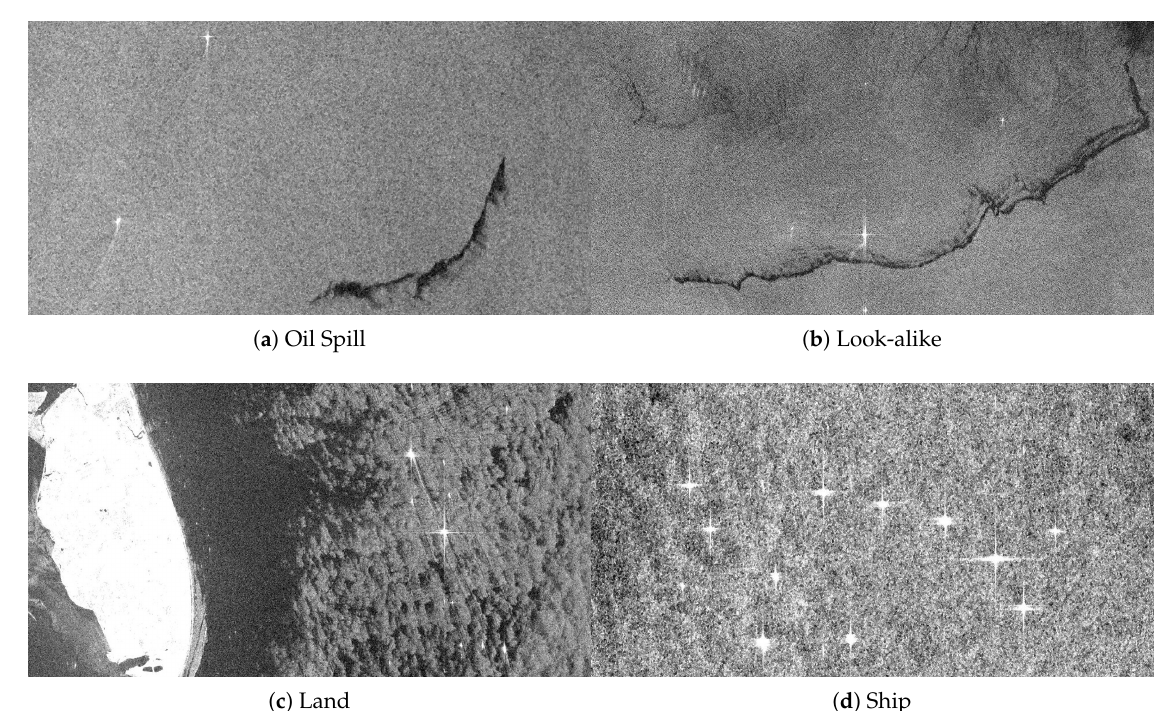
Figure 3. Dataset-1: Samples of SAR images from the European Space Agency (ESA) dataset [40]. ( a ) OilSpill, ( b ) Look-alike, ( c ) Land, ( d )